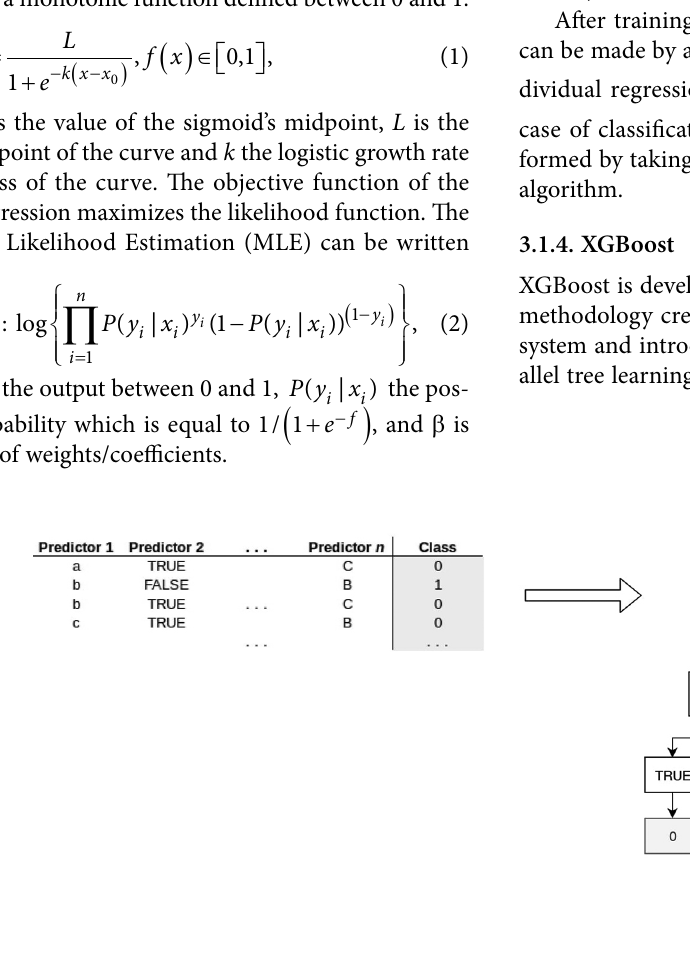
Figure 5. Generic example of decision table and decision